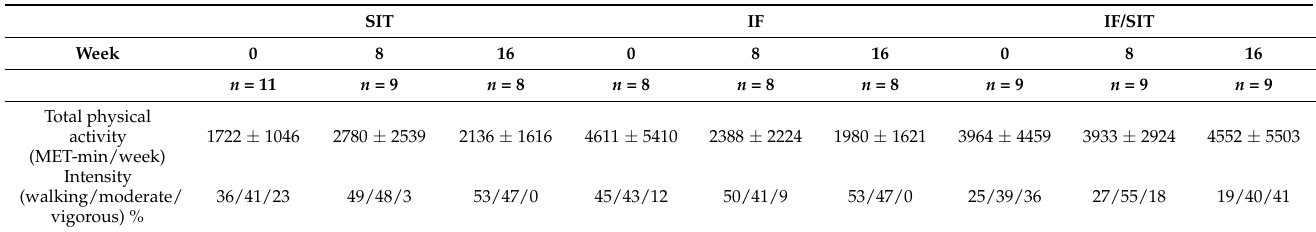
Table 6. Participants’ self-reported total physical activity and exercise intensity levels during the diet and/or exercise